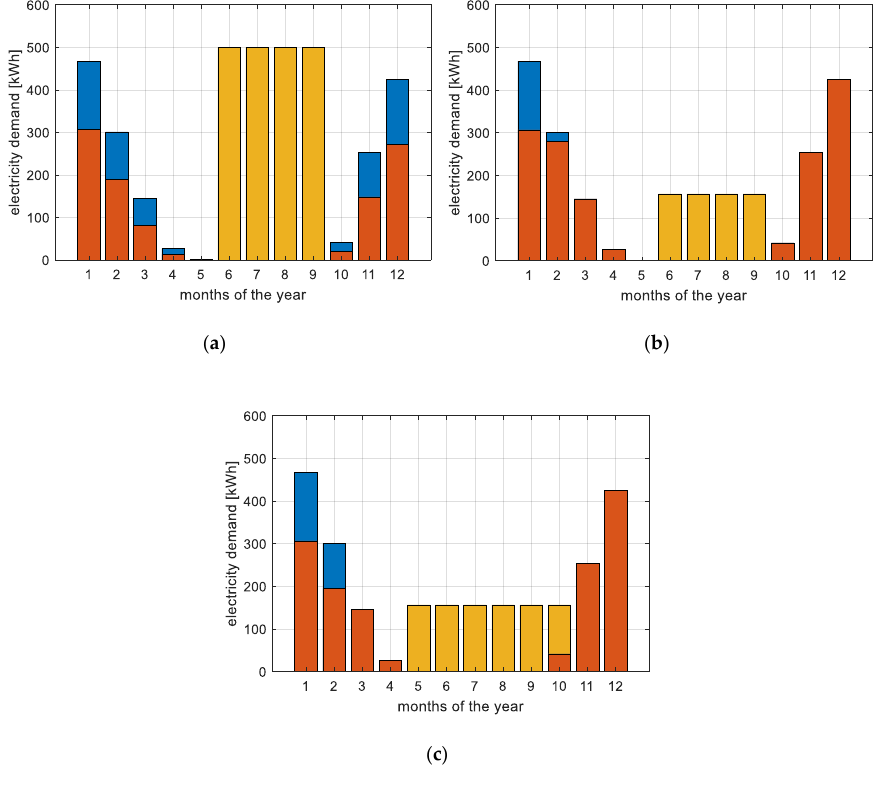
Figure 5. Monthly electricity demand of heat pump for space heating operation (discharging) with (red) and without (blue) sorption storage and charging of sorption storage (orange). For base case with 720 hours of excess electricity: ( a ) with unlimited storage capacity; ( b ) with limited storage